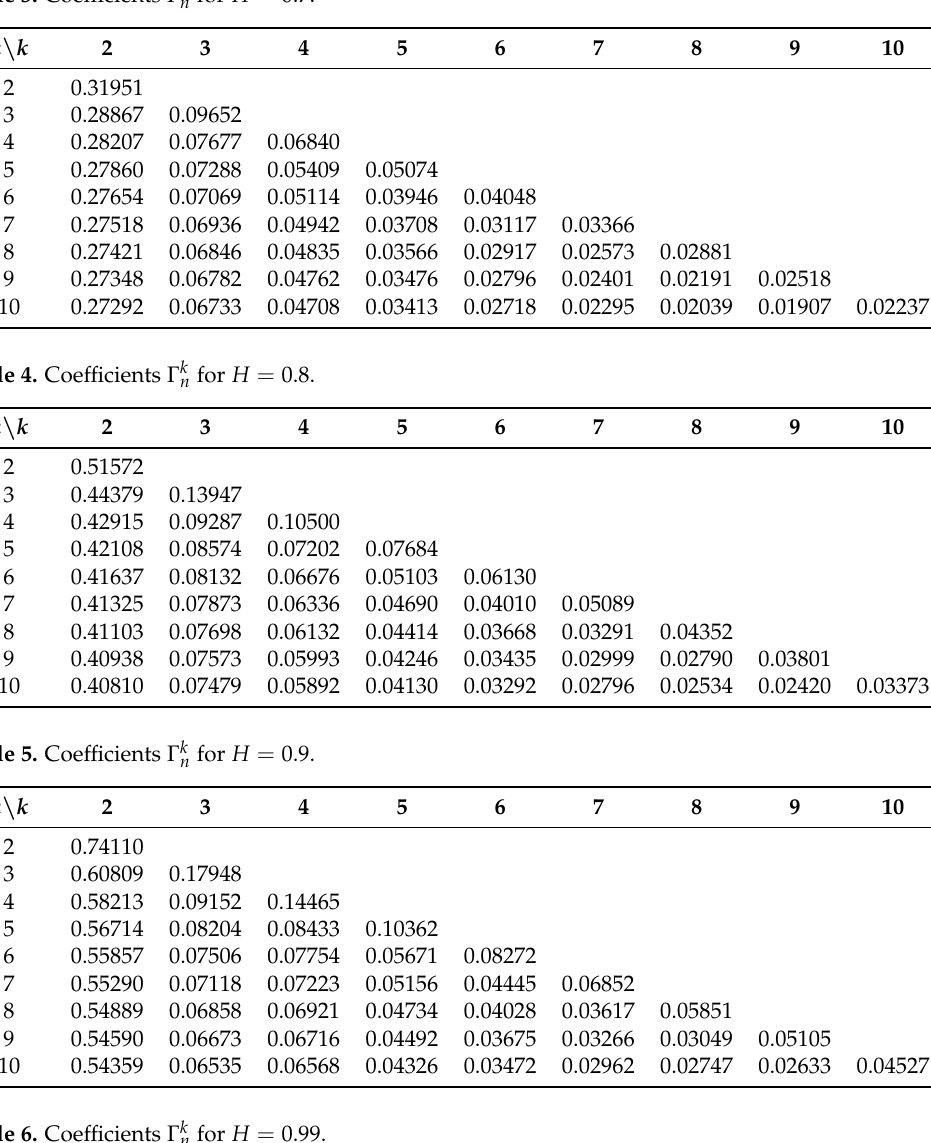
Table 6. Coefficients Γ k n for H =